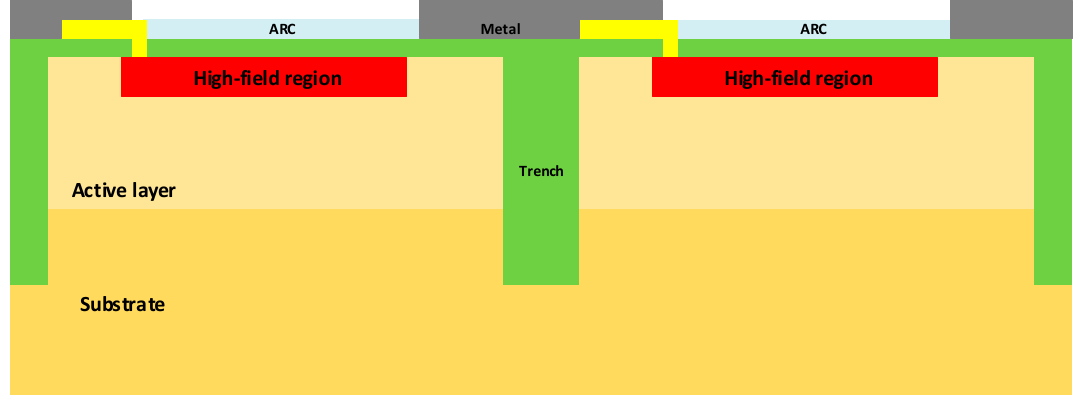
Figure 1. Structure of the cells of the NUV-HD technology (near-UV sensitive, HD stands for “high- density” of cells in the SiPM).